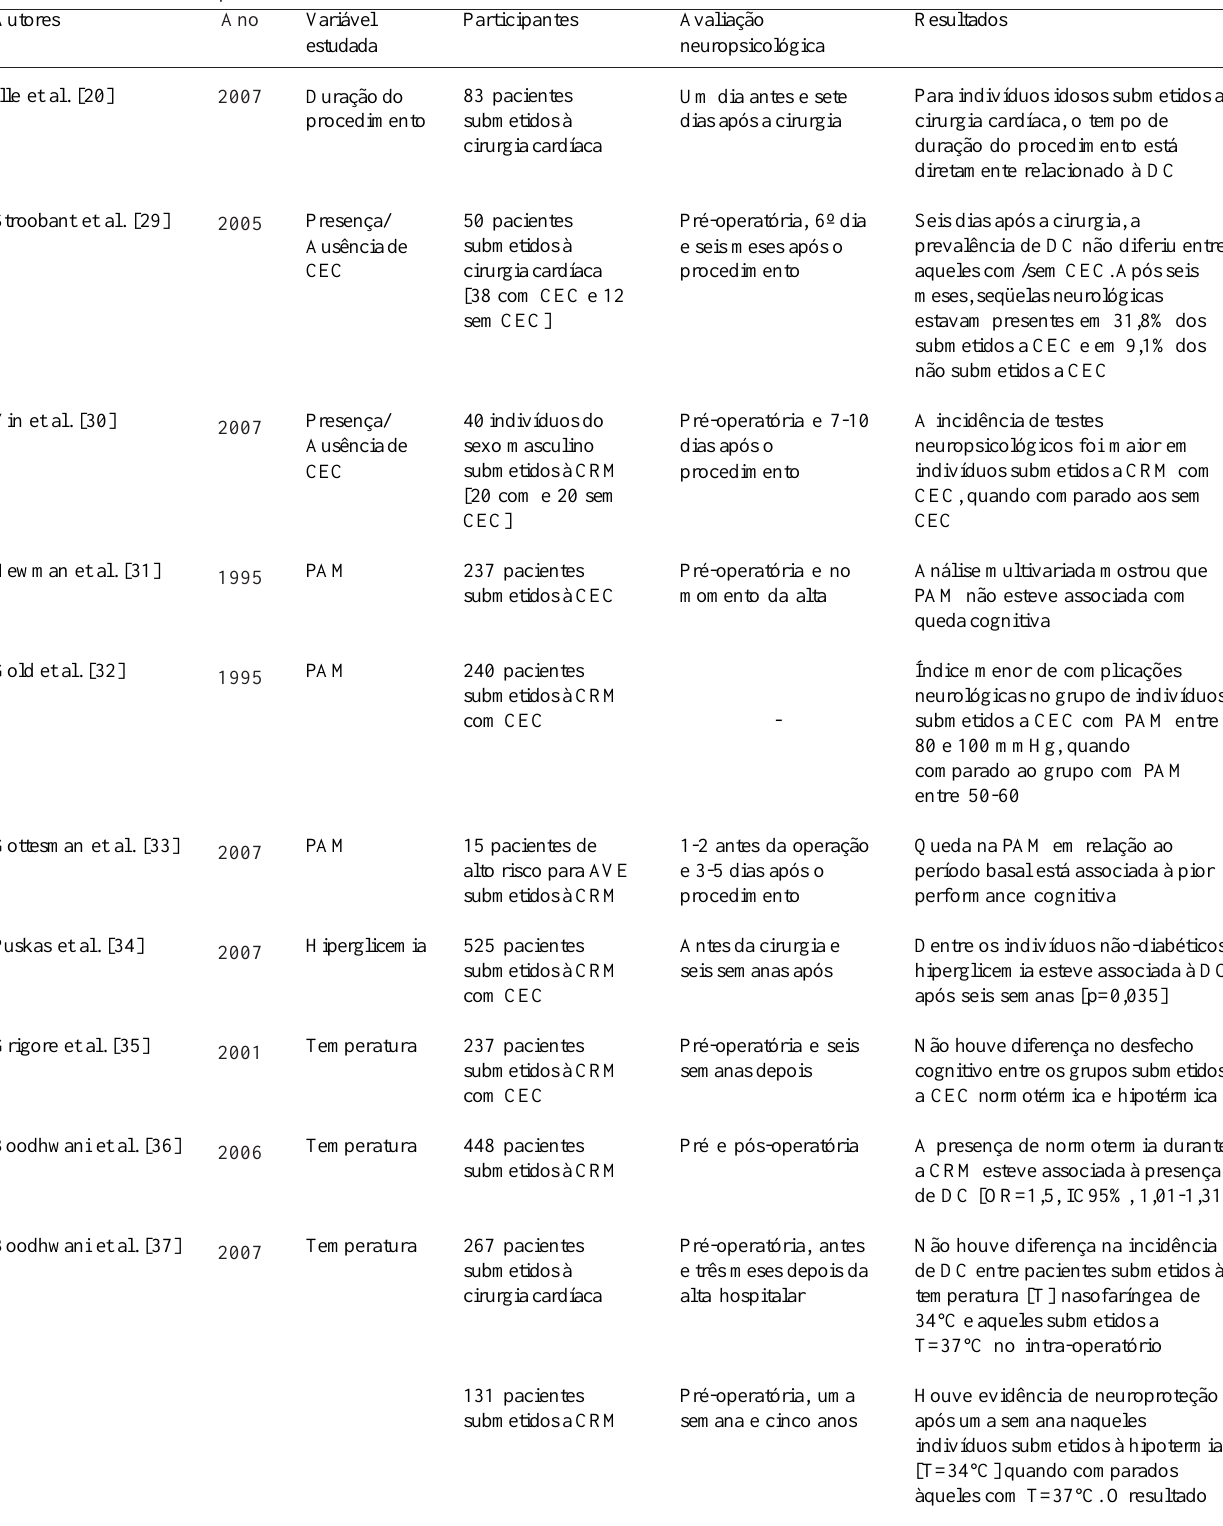
Tabela 2. Fatores